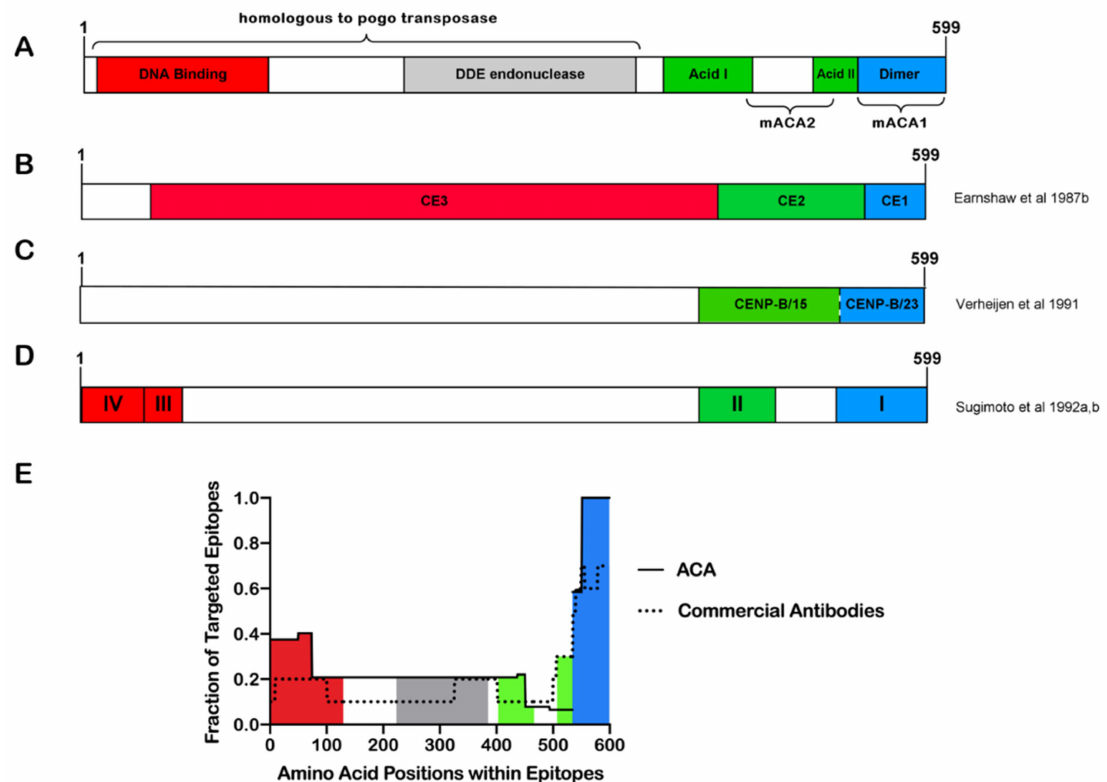
Figure 1. CENP-B domains and ACA epitopes. ( A ) The homologous region to the pogo transposase includes the DNA- binding and DDE endonuclease domains. The acidic and dimerization domains are unique to CENP-B. mACA1 and mACA2 refer to monoclonal CENP-B antibodies produced from identified ACA epitopes (Earnshaw et al. 1987). ( B ) ACA epitopes (Earnshaw et al. 1987). CE1 and CE2 correspond to mACA1 and mACA2, respectively [37]. ( C ) ACA epitopes (Verheijen et al. 1992). Only the C-terminal 147 aa were analyzed, but this region was detected in all ACA sera screened [40]. ( D ) ACA epitopes (Sugimoto et al. 1992). Epitope I was detected in all ACA sera screened [39]. ( E ) Representative distribution of identified ACA sera epitopes and reported target regions among CENP-B commercial antibodies. The CENP-B dimerization domain appears to contain the major ACA epitope. Interestingly, the majority of commercially available CENP-B antibodies target the same region, suggesting unique immunogenicity that is conserved across species. See Supplementary Table S1 for